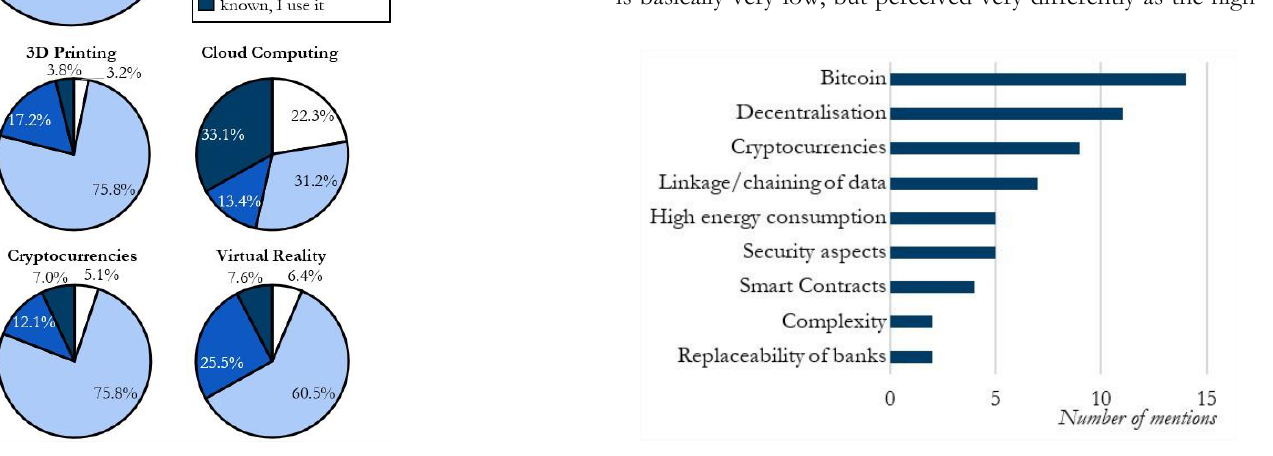
Figure 3. Associations to the stimulus “Blockchain”. Figure 2 : Awareness and usage of selected